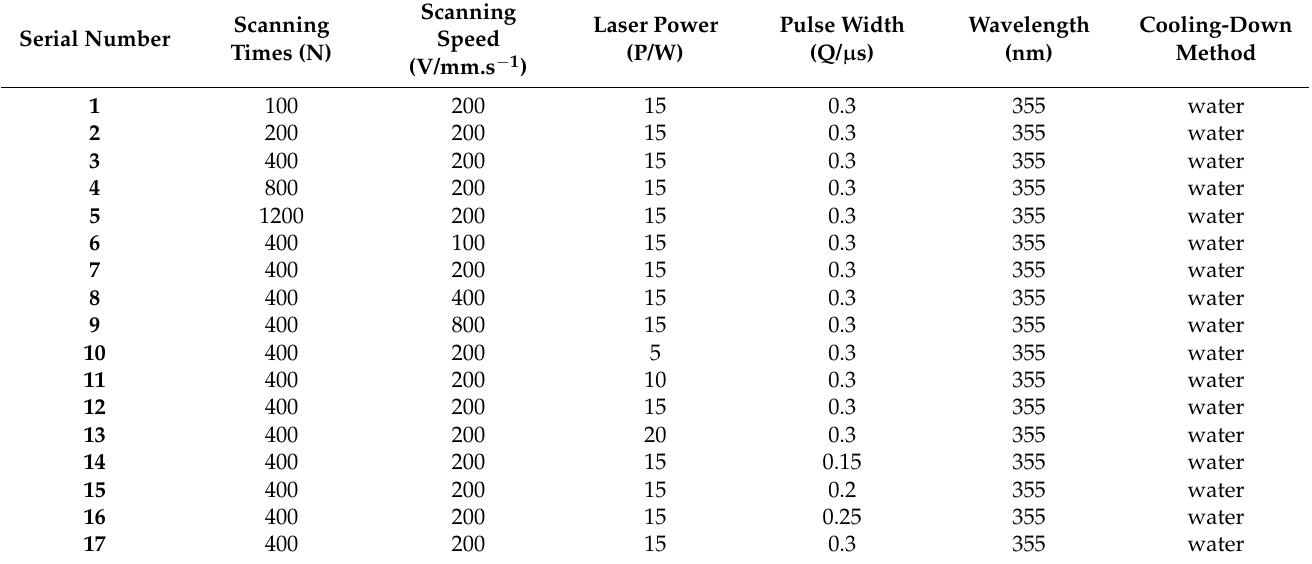
Table 4. Experimental processing